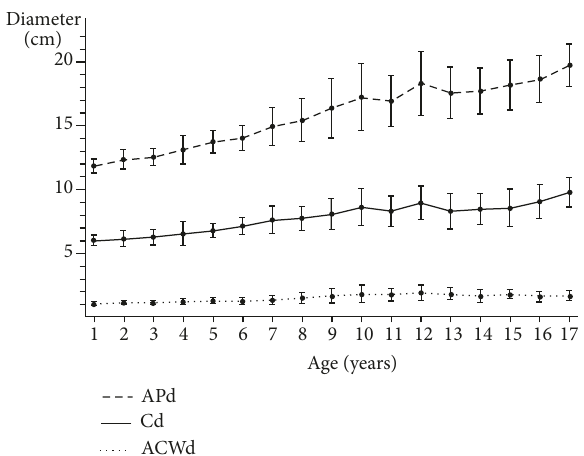
Figure 2: Means and standard deviation plots of APd, ACWd, and Cd by age group among patients aged 1–18 years. Black circles represent means and the error bars represent standard deviations. Cd: compressible